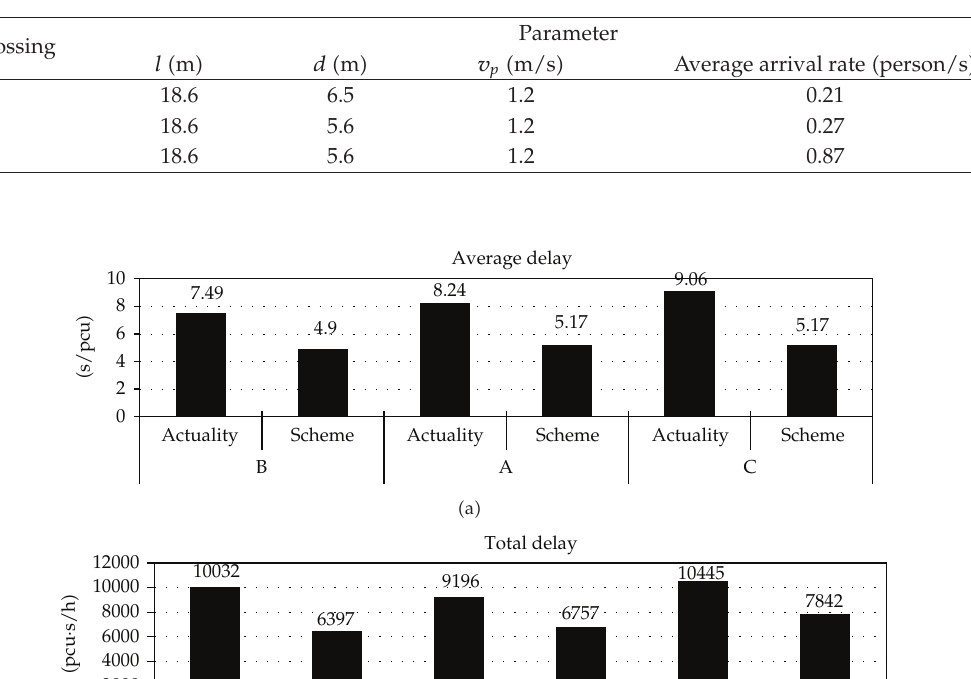
C stop line, and the controls parameter optimization model formula (cid:4) 2.6 (cid:5) and (cid:4) 2.7 (cid:5)